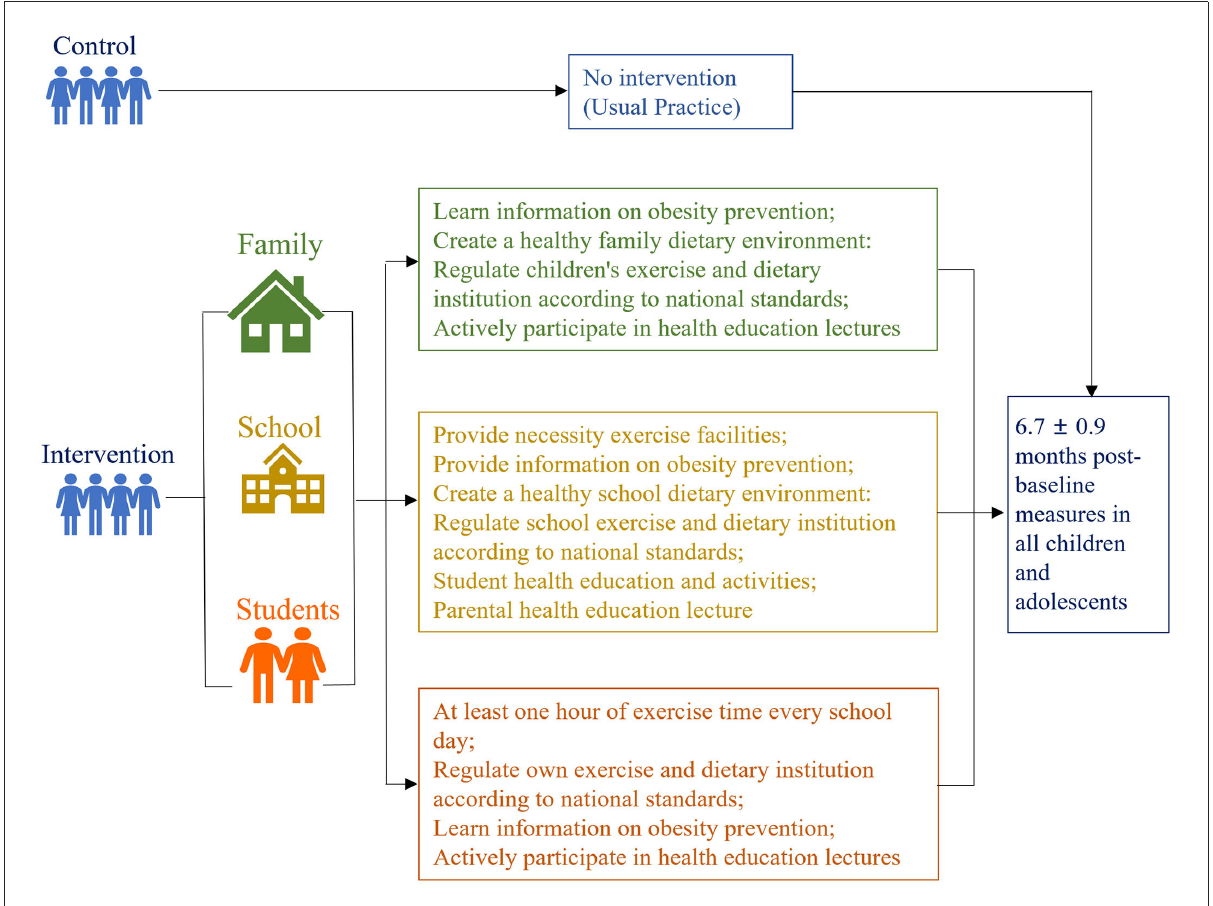
FIGURE1 Comprehensive intervention strategy of the